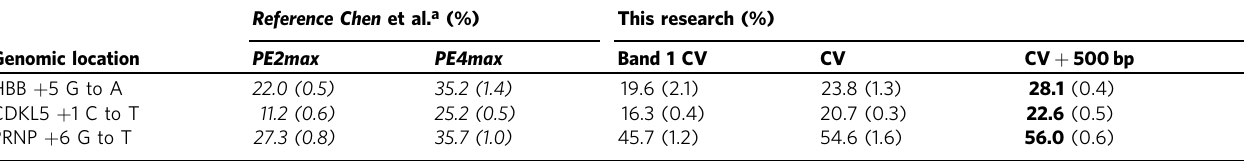
a Prime editing ef fi ciency estimated from Fig. 7D in Chen et al. 15 ; values in () represent standard deviation of three data points. Column entries for our results stating Band 1 CV are editing with band 1 extracted using gel electrophoresis. CV denotes 452bp Circular Vectors prepared by our protocol. CV + 500 pad denotes added 500bp padding to lengthen guide expression vectors to 952bp. All entries in our results are the averages and standard deviations (in round brackets) from four independent samples provided by EditR analysis of Sanger sequencing traces, with exception of HBB Band 1 CV representing average of three samples. Edits performed on 24-well plates, using 4X guide molar excess (see Transfection, Handling, and Sequencing of Edited HEK293T Cells in Methods). Highest editing ef fi ciency achieved is shown in